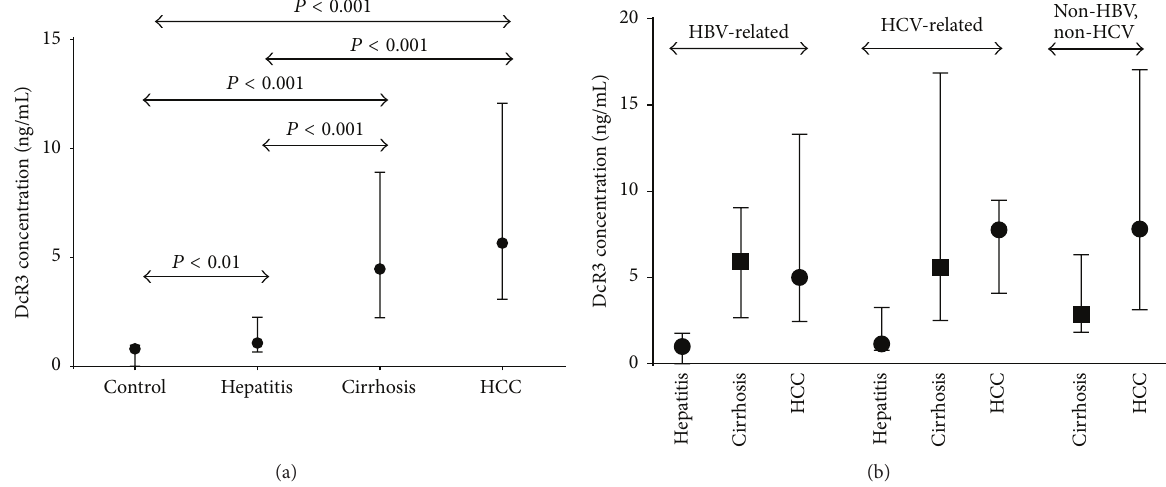
Figure 1: (a) DcR3 protein is highly elevated in the systemic circulation of patients with chronic liver disease. (b) sDcR3 levels are dependent upon the presence of cirrhosis and not the underlying cause of liver disease. Concentration of DcR3 in the sera was measured by ELISA. Values are expressed as median ± interquartile range. Comparison between groups was performed by Mann-Whitney test.